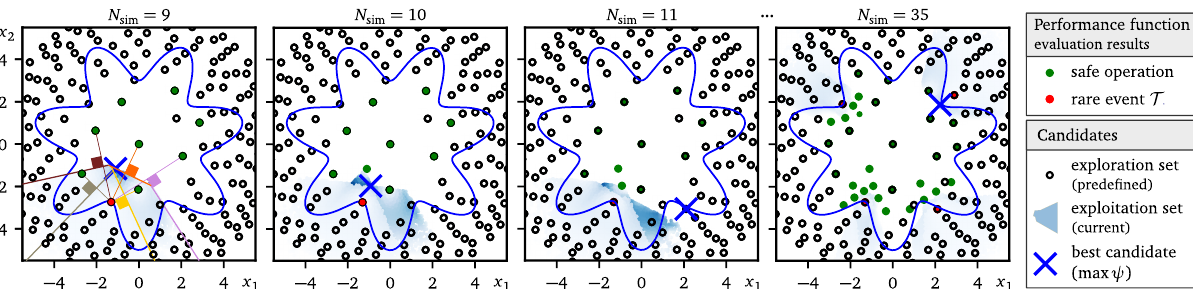
Figure 2. Two-dimensional illustration of the combined set candidates and the selection process (standard Gaussian space) for a binary performance function dividing the space into a ”flower-shaped” safe domain and the surrounding failure domain. At N sim = 9 model evaluations, the rare event is hit for the first time. At N sim = 10 an exploitation candidate is selected, while at N sim = 11 the exploration candidate wins using the highest value of the ϕ criterion expressed by the blue color saturation. A complete evolution of the extension of the ED using the ϕ -based selection process for another run of the same problem is available as a video